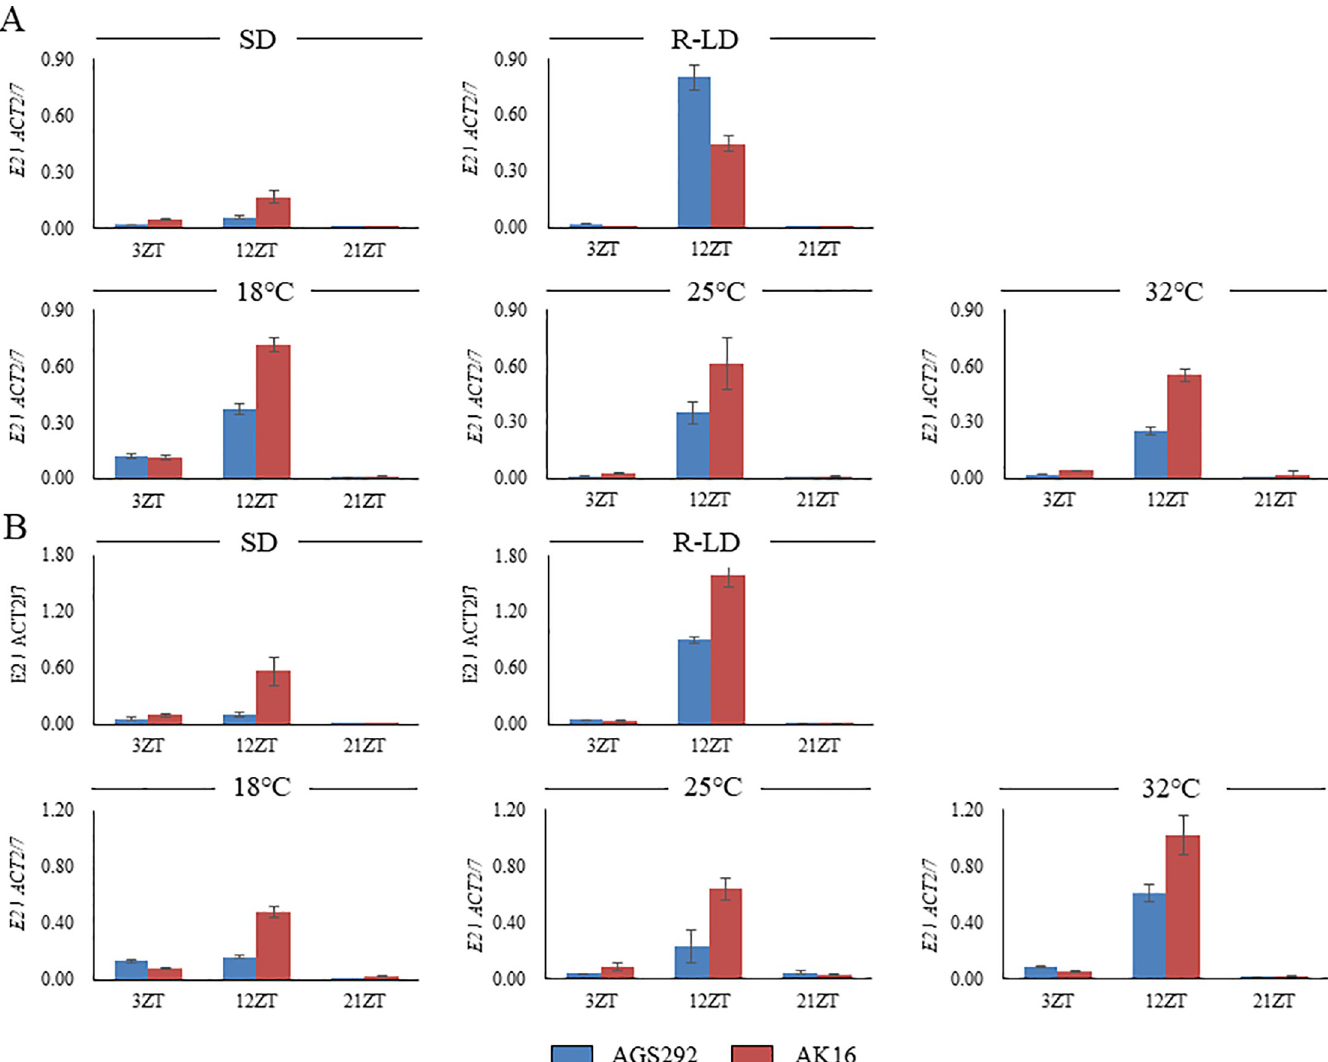
Fig 8. Expression profiles of E2 in soybean lines AGS292 and AK16 under different photo-thermal conditions. (A) Second trifoliate-leaf stage, (B) Fourth trifoliate- leaf stage.